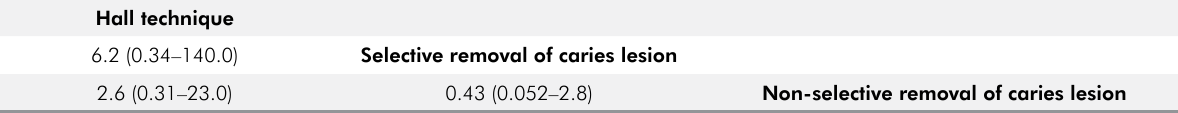
Table 3. League table with all mixed* comparisons of treatments for deeper caries lesion with pulp